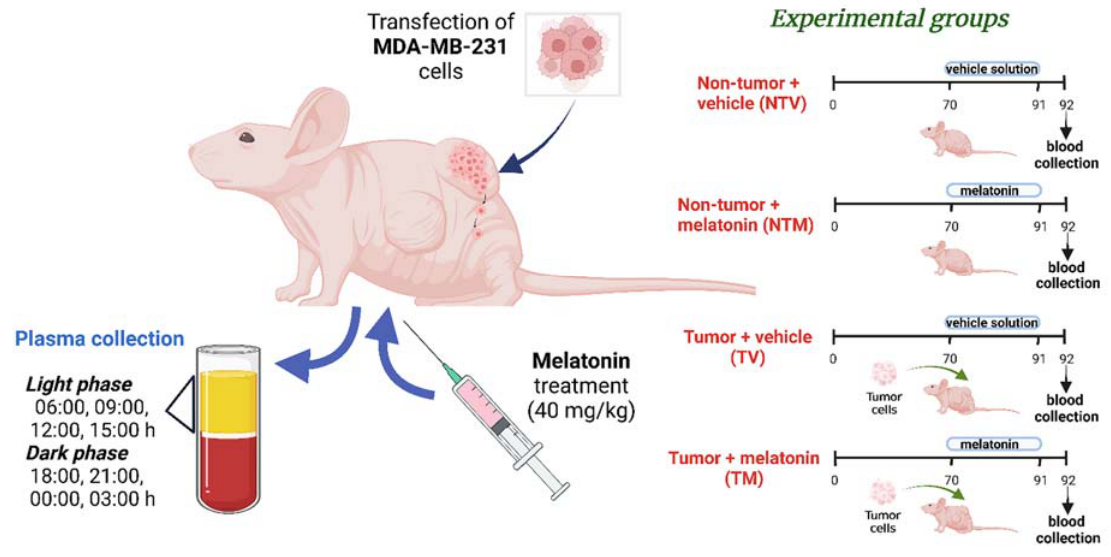
Figure 10. Representative illustration of the experimental procedures. After MDA-MB-231 cells were subcutaneously inoculated in female nude mice, the xenografted BC became apparent within a few days and four experimental groups were formed. Melatonin or vehicle solution was adminis- tered by intraperitoneal injections over 21 days. At 92 days of age, blood collection was carried out following eight specific time points. NTV: non-tumor animals treated with vehicle, NTM: non-tu- mor animals treated with melatonin, TV: tumor animals treated with vehicle, and TM: tumor ani- mals treated with melatonin.